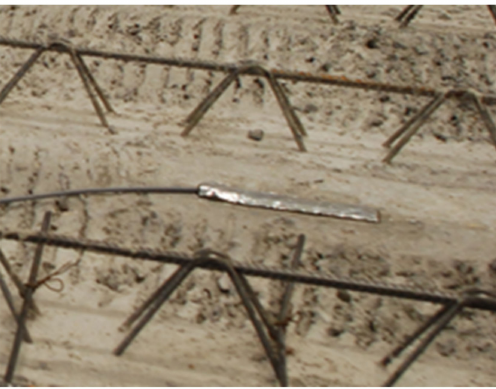
Figure 1. Fitting a strain gauge onto the surface of the lost formwork (reinforced concrete